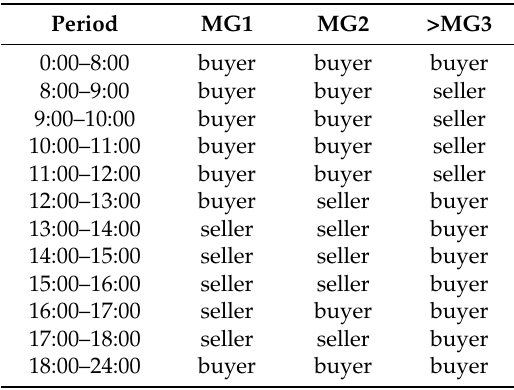
Table A1. Roles of Energy Table 4. Roles of Energy Trading.